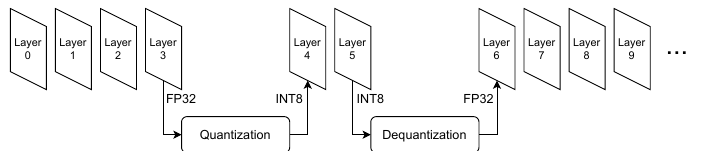
Figure 4. Cross inference procedure with quantization and